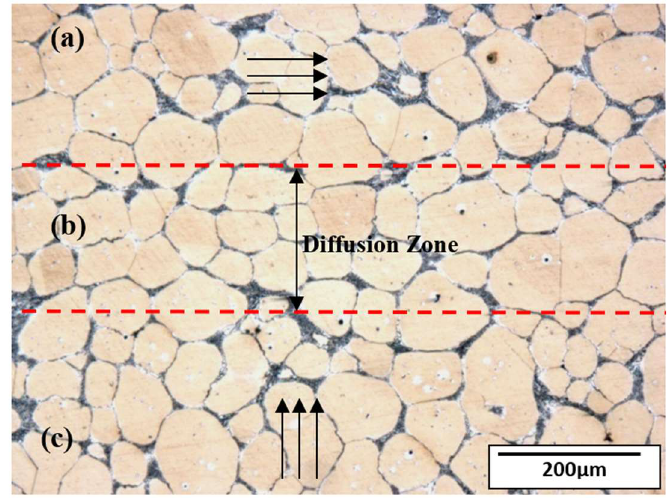
Figure 7. Microstructure of thixo-weld-joint of ( a ) base metal, ( b ) diffusion zone ( c ) insert, after subjecting to 1300 °C heating temperature for 10 min.